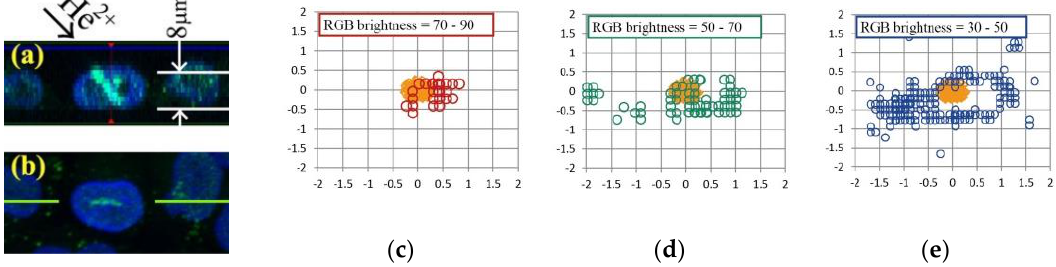
Figure 17. Fluorescent lines corresponding to the ion track in a HeLa cell nucleus: ( a ) cross-sectional view of the irradiated cells at the green horizontal line in the bottom view [56]; ( b ) bottom view of the cell [56]; and ( c – e ) pixel distributions with selected brightness.